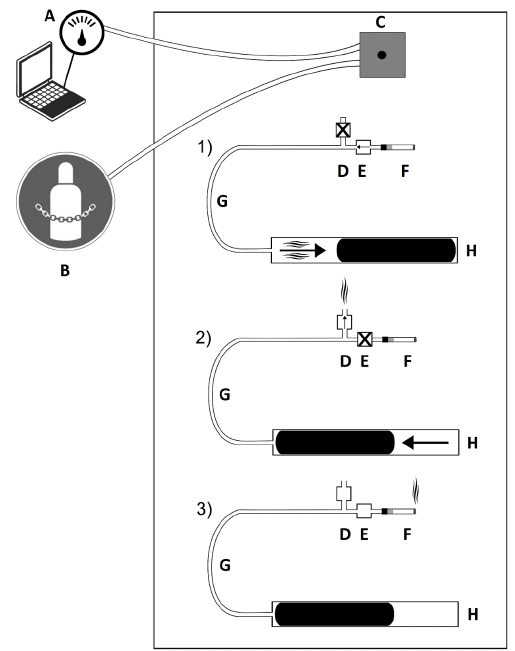
Figure 1. Diagram of the experiment. Outside the measuring chamber: A = Laser aerosol spectrometer (LAS) connected with computer. B = Compressed air supply. Inside the measuring chamber: C = Suction point and dilution system connected with LAS and compressed air supply via tubes. D = Outlet valve. E = Intake valve. F = Cigarette. G = Polyamide tube. H = Programmable smoke pump. (1) Smoke pump (H) takes a puff on the cigarette (F). Outlet valve (D) is closed. (2) Smoke pump (H) puffs out the smoke into the measuring chamber. The intake valve is closed. (3) Phase between two drags on the cigarette. Cigarette (F) smolders.